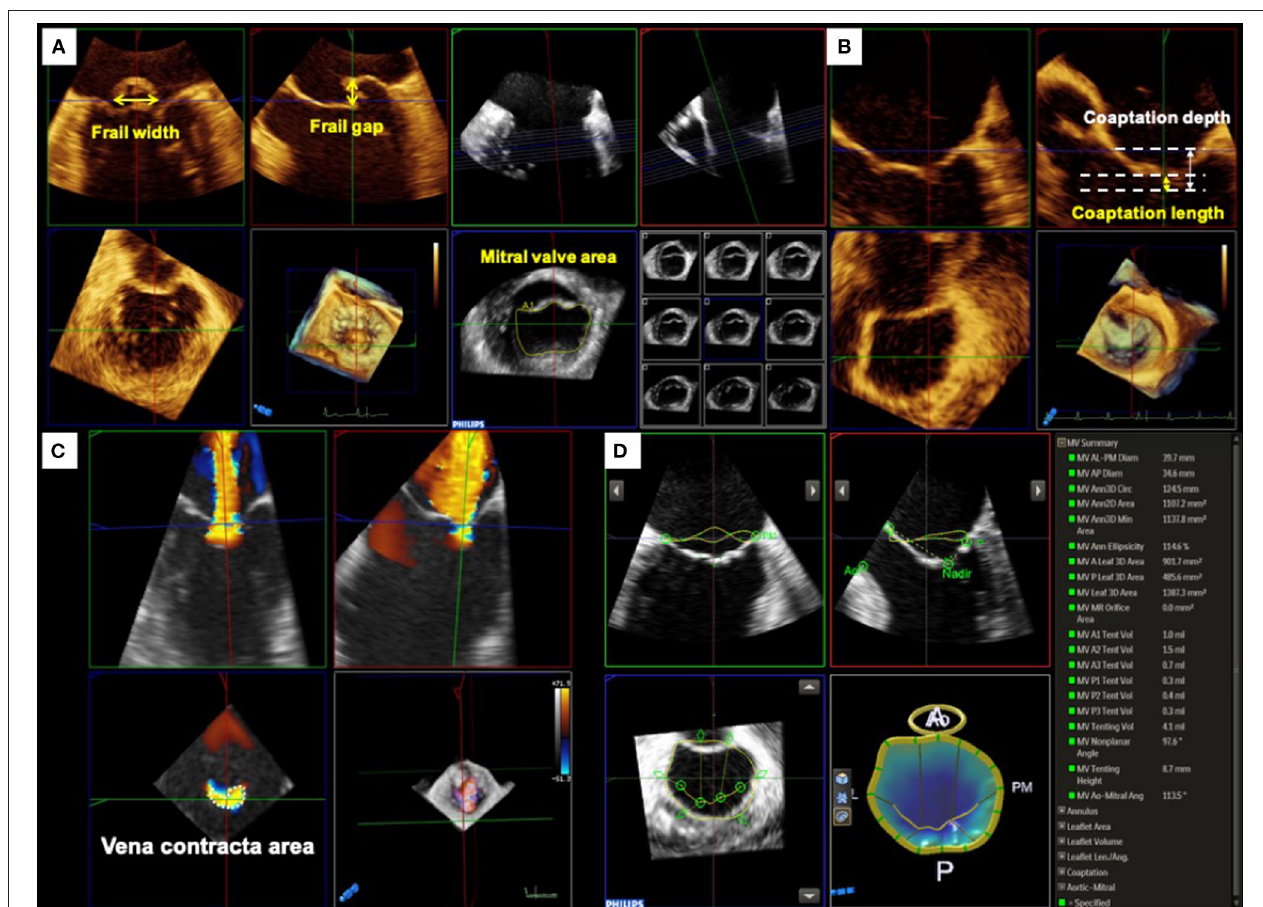
FIGURE 1 | Pre-procedural assessment and quantification of mitral valve geometry. (A) Primary mitral regurgitation. For treating primary MR with MitraClip, the frail gap and width of the lesion and mitral valve opening area are used for assessing the procedural durability. (B) Secondary mitral regurgitation. Whereas, the coaptation depth and length should be evaluated for secondary MR. (C) Quantification of mitral regurgitation by three-dimensional (3D) color Doppler. Three-dimensional vena contracta area allows to evaluate regurgitant orifice area directly and may improve the assessment of regurgitant severity. (D) MV geometrical assessment using Mitral Valve Navigator A.I. . Semi-automated software dedicated to MV quantification provides useful information on the MV geometry from 3D TEE